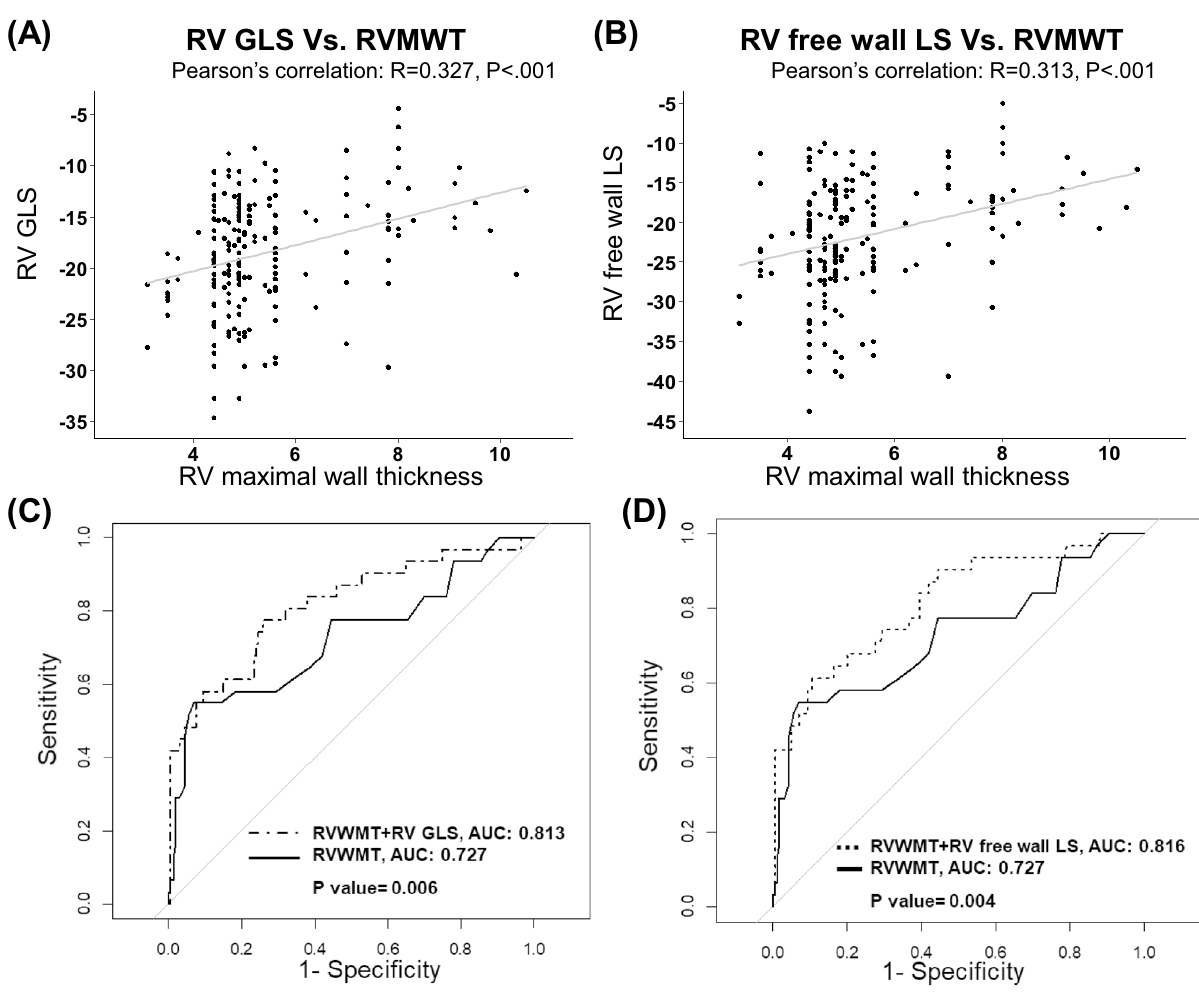
Figure 3. Scatter plot and Pearson correlation coefficient between (A) right ventricular maximal wall thickness (RVMWT) and RV global longitudinal strain (GLS) and (B) RVMWT and RV free wall longitudinal strain (LS). Comparison of receiver operating characteristic curves with corresponding areas under the curve to predict RV involvement between (C) RV wall thickness and RV wall thickness with RV GLS and (D) RV wall thickness and RV wall thickness with RV free wall